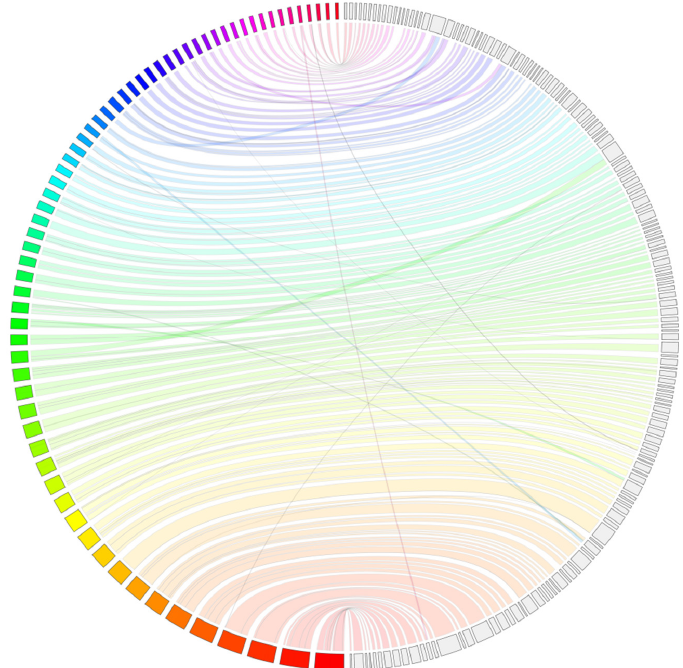
Figure 1. Jupiter plot. A global genome alignment, using BWA-MEM, of the grizzly genome (left side of circle) to the polar bear genome (right side). Connections show the aligned regions of each assembly. The grizzly scaffolds are limited to those over 10 Mb in length (>85% of the assembly). The longest polar bear scaffolds were selected to sum to the same amount of sequence (2 Gb). Only alignments over 10 kb in length are displayed.